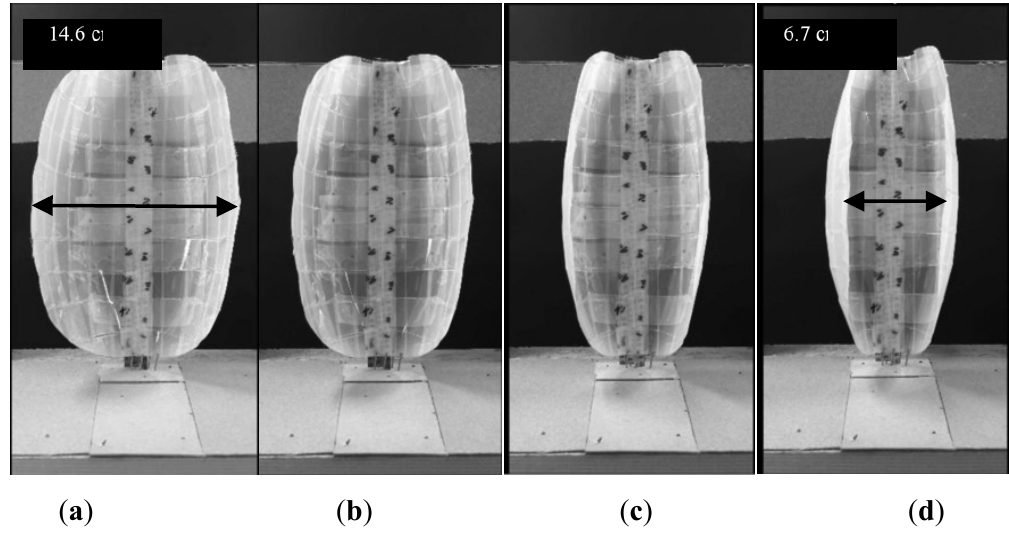
Figure 10. Physical small scale prototype, before ( a ) during ( b ), ( c ) and after ( d ) a temperature increase is applied to the connecting beam provides insight into the geometric and mechanical relationships between the beam and shell